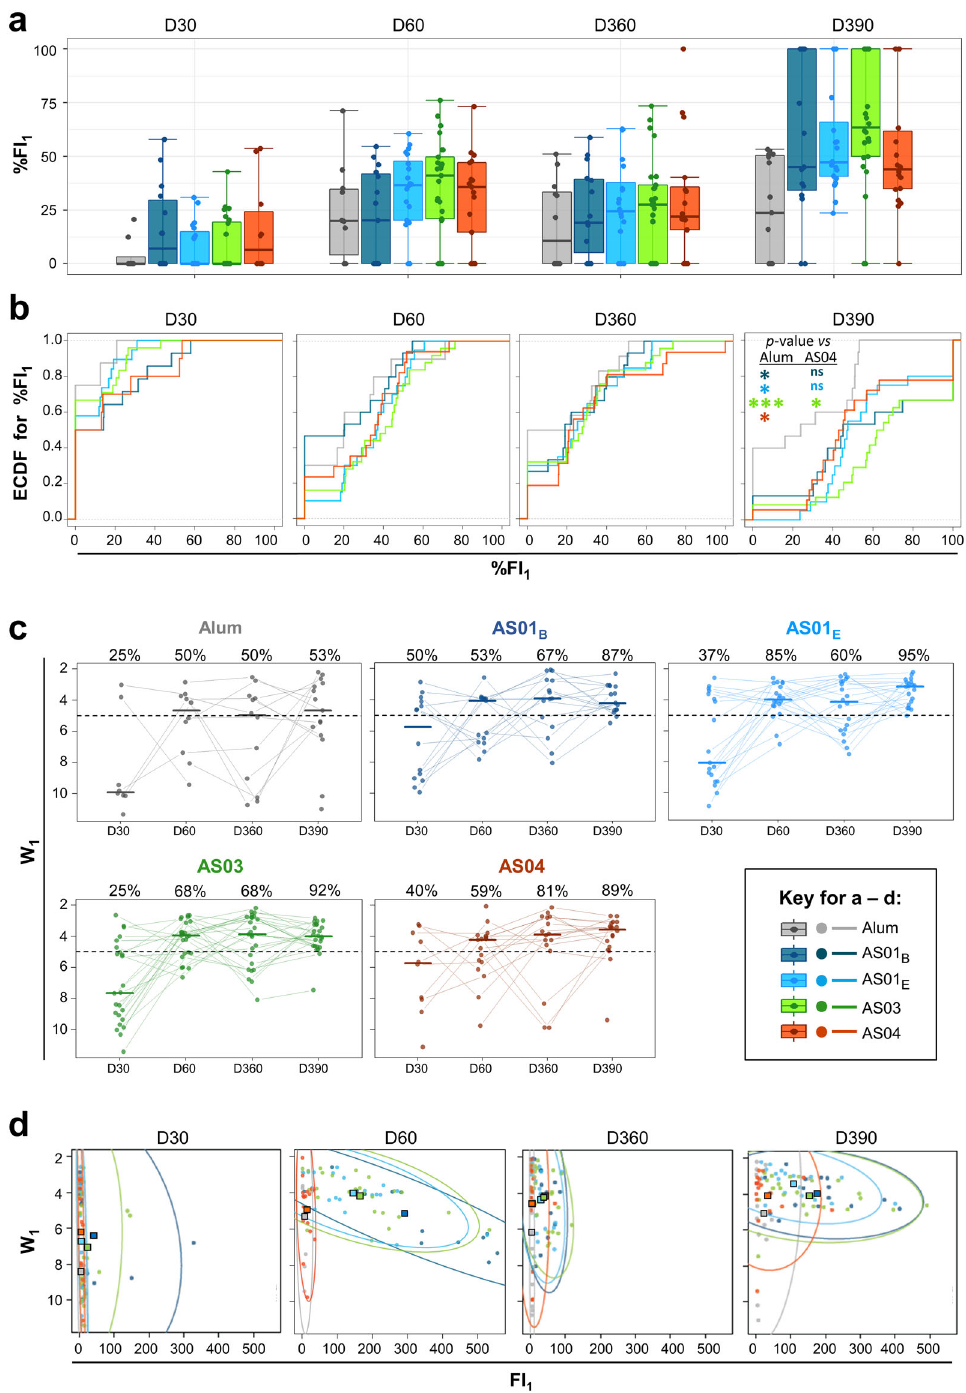
Fig. 4 Adjuvant Systems stimulate avidity maturation before and after antigen recall. Data for the Avidity cohort ( N = 95) are color-coded by adjuvant group according to the key in the fi gure ’ s center. FI 1 , fl uorescence intensity attributable to fi rst-component antibodies. a Frequencies of fi rst-component antibodies in the total HBsAg-speci fi c antibody population (%FI 1 ) are shown. Boxplots represent medians, interquartile ranges (IQR), and ±1.5 IQR. b Empirical cumulative distribution function (ECDF) curves of the subjects are plotted against %FI 1 data. For a given value of t %FI 1 , ECDF( t ) represents the fraction of subjects in the respective group with %FI 1 ≤ t . Groups for which the curve is shifted to the right are composed of subjects with increased %FI 1 values. Curves were compared by a one-sided Kolmogorov-Smirnov test without correction for multiplicity. Asterisks indicate levels of signi fi cance by color-coded group (* p < 0.05, ** p < 0.01, *** p < 0.001). c . Avidity of fi rst-component antibodies (W 1 ) is shown. Each symbol represents a subject. Gray lines connect results from the same subject. Horizontal solid lines represent group medians. Dotted lines represent the threshold dividing subjects with either high-avidity (W 1 < 5) or medium-to low-avidity (W 1 ≥ 5) antibody pro fi les. Numbers above the plots represent percentages of subjects in the group with high-avidity pro fi les, by timepoint. d . FI 1 , W 1 plots show 95% con fi dence intervals ( ellipses), group means (squares), and individual subjects (dots). Ellipse extensions re fl ect either higher numbers of high-avidity antibodies (shift on the x -axis to the right), or increased antibody avidity (upward shift on the y - axis). Upper-right corners represent the optimal situation: a high abundance of high-avidity